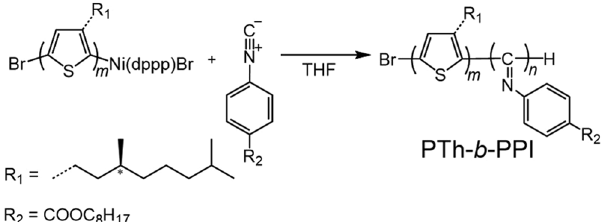
Figure 1. Molecular design. Synthetic route for PTh- b -PPI through Grignard metathesis (GRIM) reaction in one-pot. dppp = 1,3-Bis(diphenylphosphino)propane. THF =